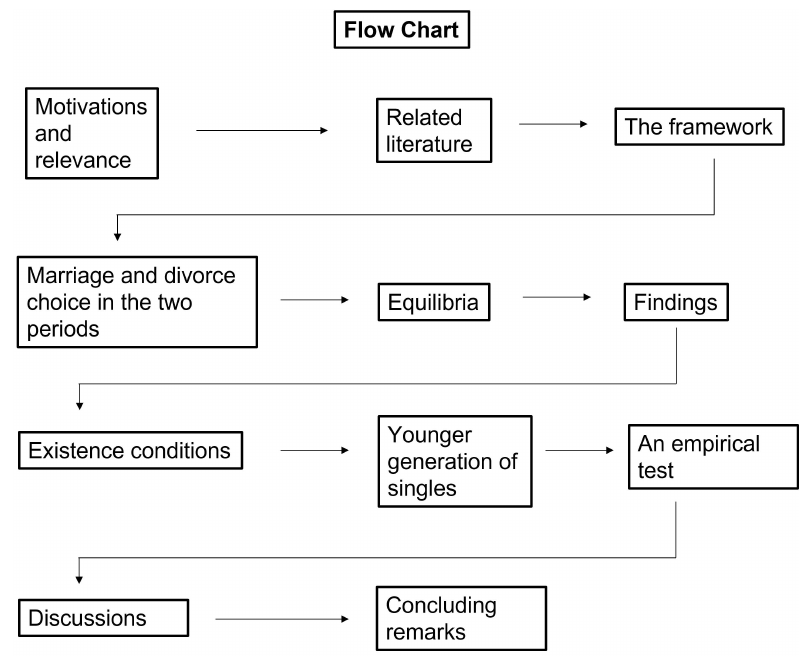
Figure 1. Roadmap of this